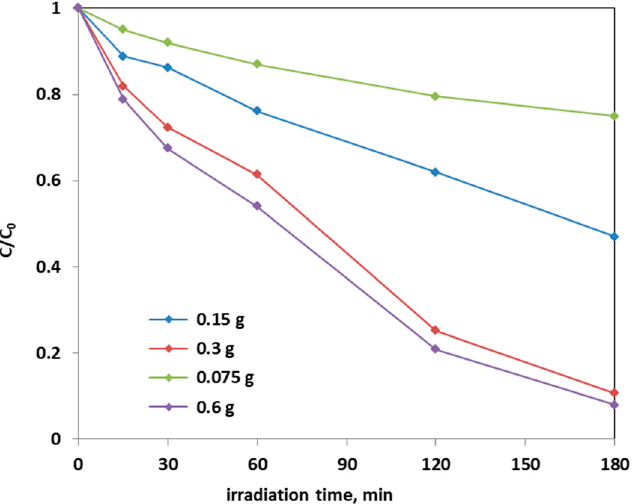
Figure 12. Photocatalytic discoloration of AO7 with different loads of the optimized Fe(2.5)-TiO 2 sample under visible light irradiation.